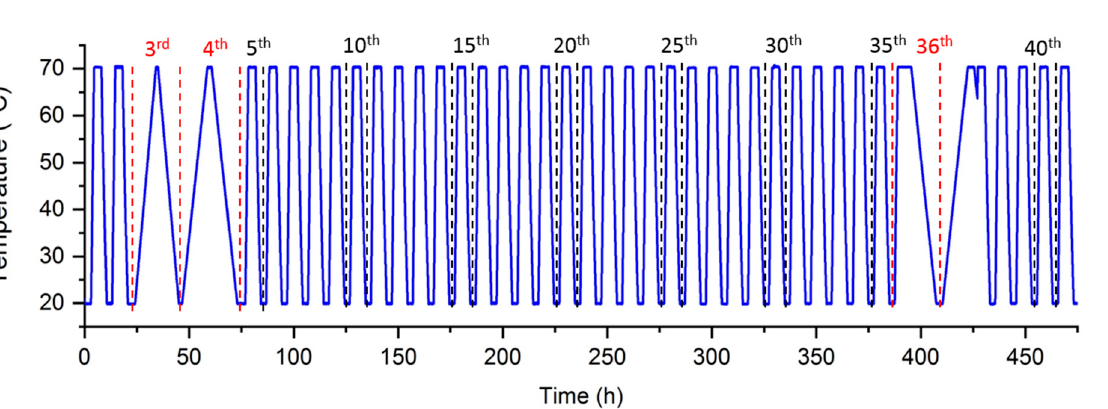
Figure 14. Probability distribution of crystallization temperatures for SAT58%. In the inset, the crystallization temperature has a 0.1 °C temperature step. Better repeatability of the crystallization temperature was found in these 35 cycles (after exclusion of the 1st, 3rd, 4th, 5th, 36th, and 37th) with values between 45 and 47 °C. It can be noted that the temperature distribution is more homogeneous. As shown in Figure 4, a copper welding rod was previously inserted in the liquid SAT58%. Copper may have been corroded by SAT and particles may be present in the SAT’s solution, pro- moting the solidification of the material. The mean temperature obtained was 𝑇 (cid:3004) = 46.1 °C, with a standard deviation 𝜎 = 0.5 °C. The whole crystallization temperatures are included in the distribution range and the consideration of singular points would not be needed for this SAT58% sample. The evolution of the latent heat throughout cycles was then determined, and the results are shown in Figure 15.